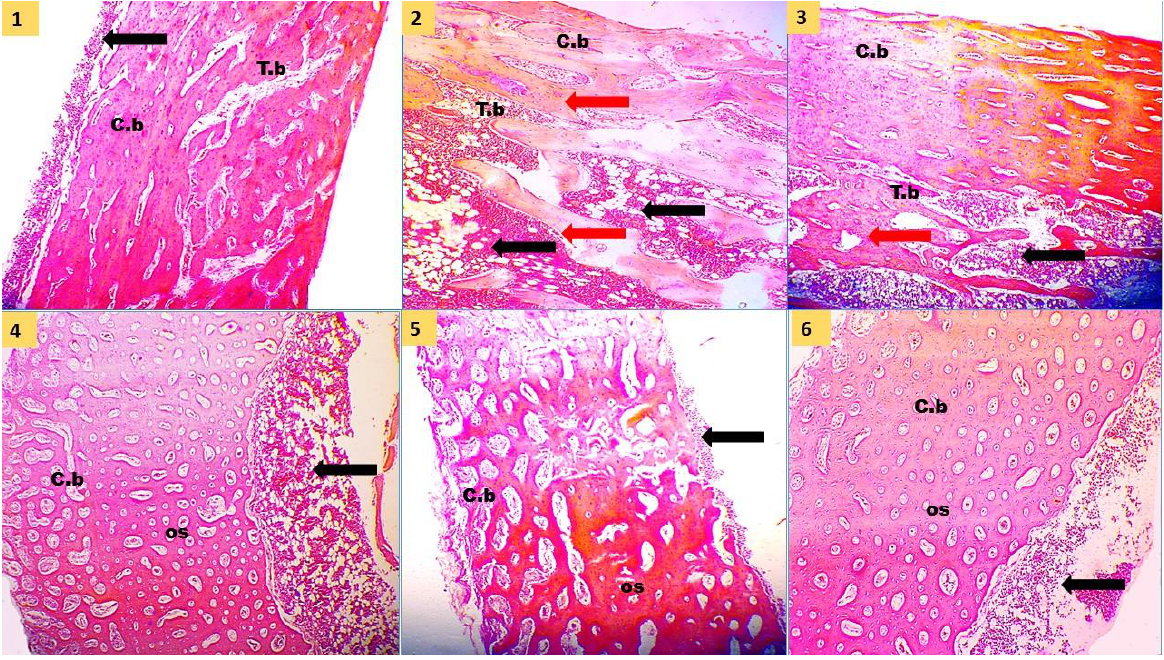
Figure 1. Photomicrograph of the histological structure of diaphysis of tibia in broiler chickens at 35 d of age showed cortical compact bone (C.b) with its osteons (os), medullary trabecular bone (T.B) with its bone trabeculae (red arrow), and bone marrow (black arrow). Hematoxylin and eosin stain (H & E, x40). ( 1 ), Positive control diet contained the recommended Ca and nPP; ( 2 ), negative control diet contained the recommended level of Ca and low nPP; ( 3 ), NC + 600 U phytase/kg of the diet; ( 4 ), NC + 0.05% multi-strain probiotic; ( 5 ), NC + 0.2% Saccharomyces cerevisiae ; and ( 6 ), NC + 0.2% fumaric acid.